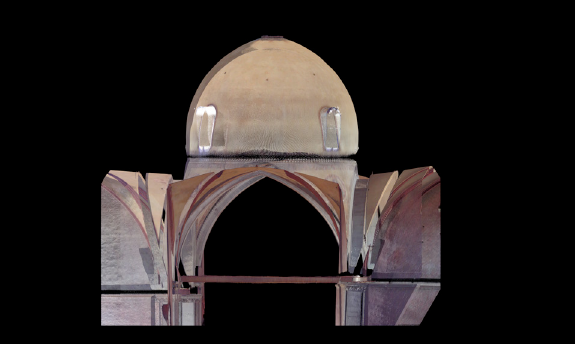
Figure 7. Image of the point-cloud of the intrados of the Basilica's